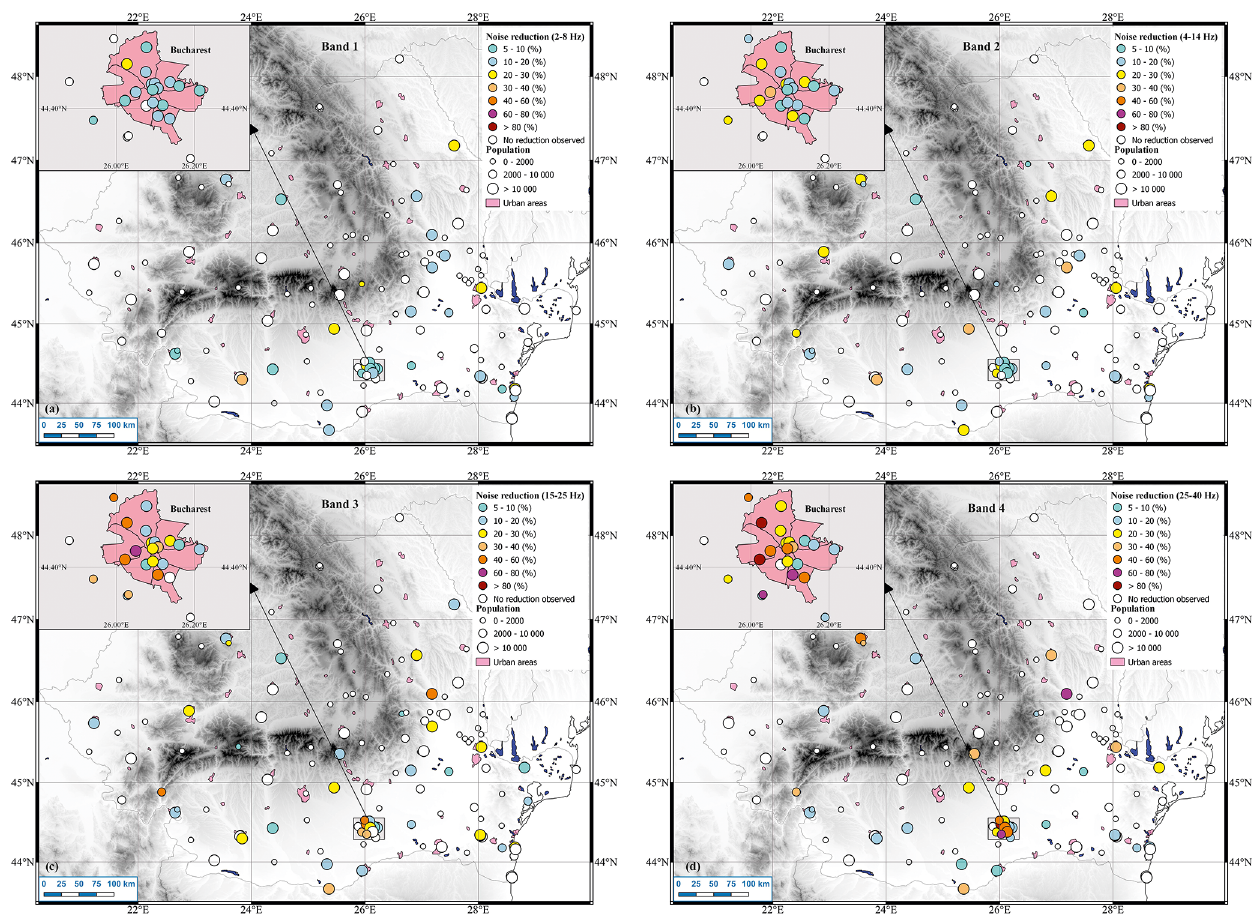
Figure 2. Percent change in DRMS during the period 25 March–23 April 2020 (right after the stay-at-home order entered into force) with respect to the interval 10 February–10 March 2020 in the frequency bands (a) 2–8Hz (Band 1), (b) 4–14Hz (Band 2), (c) 15–25Hz (Band 3), and (d) 25–40Hz (Band 4). For each site, we show a circle colored according to the maximum percentage of the noise reduction in each band and sized as a function of the number of inhabitants in the